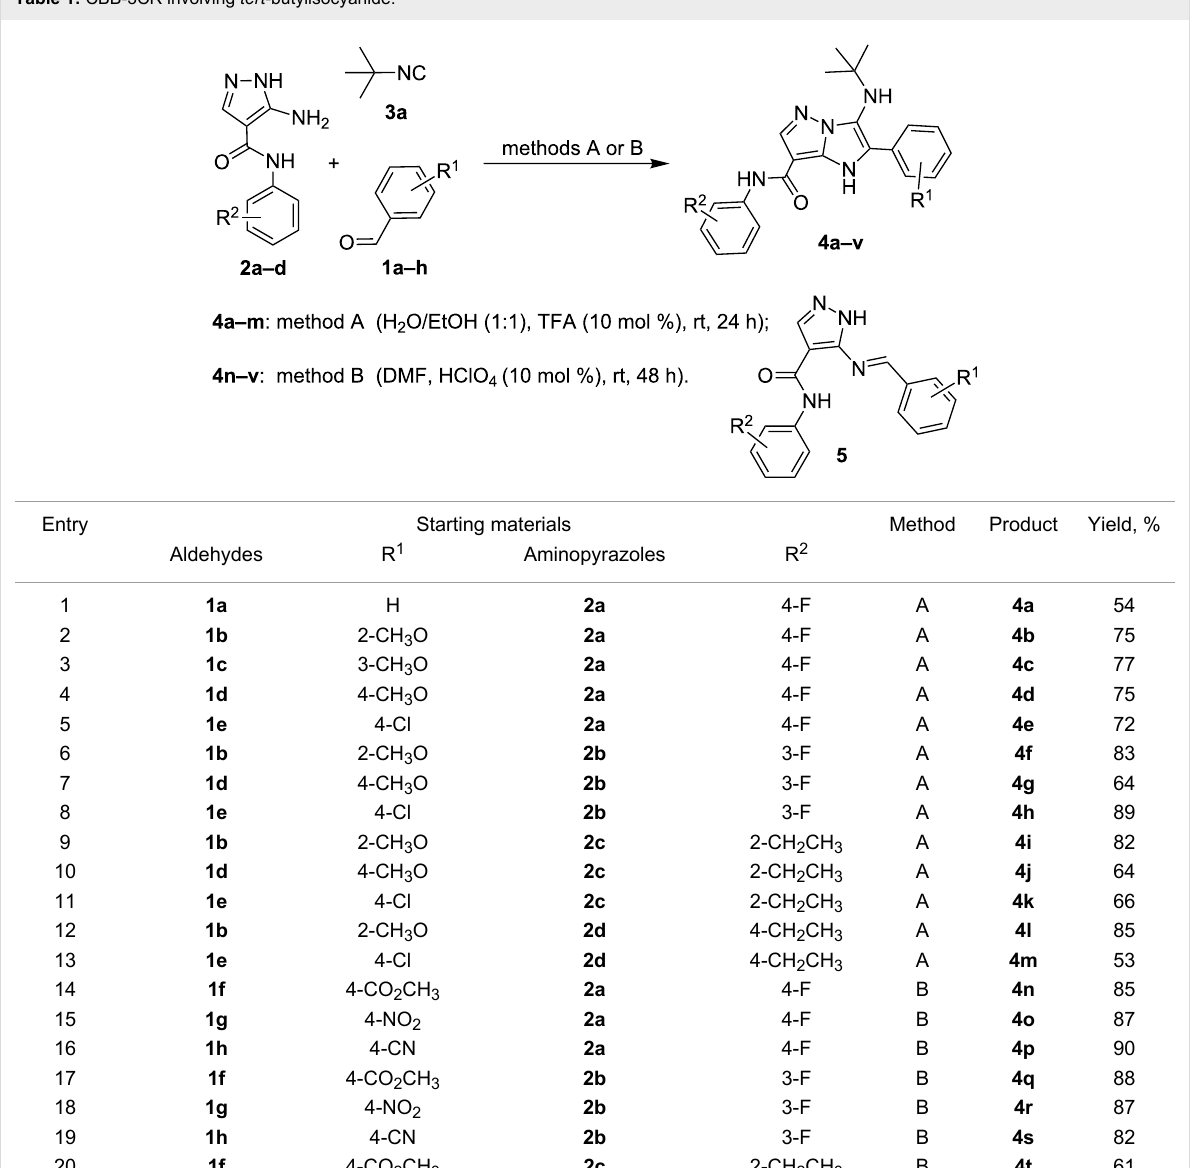
Table 1: CBB-3CR involving tert